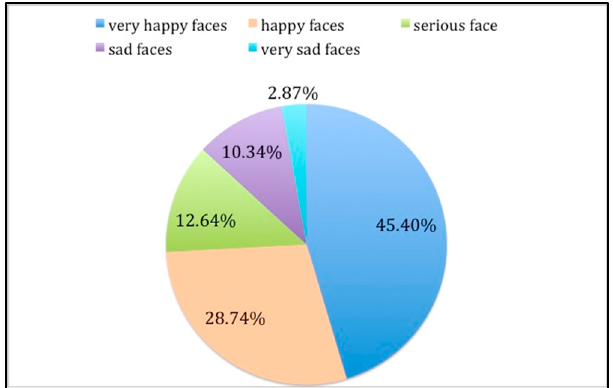
Figure 2. Pie chart of the faces chosen with the Wong–Baker faces scale. Table 4. Chi-square test and Cramer’s V applied to the different variables studied and the Wong– Baker faces